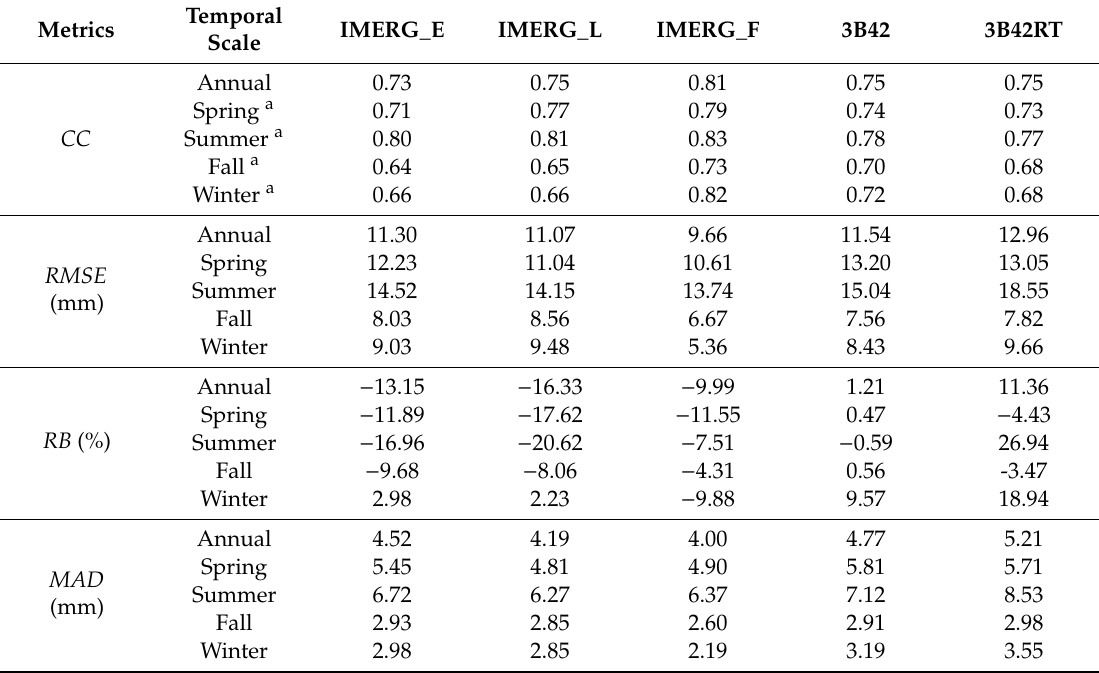
Table 3. Mean continuous evaluation metrics of the SPPs at daily